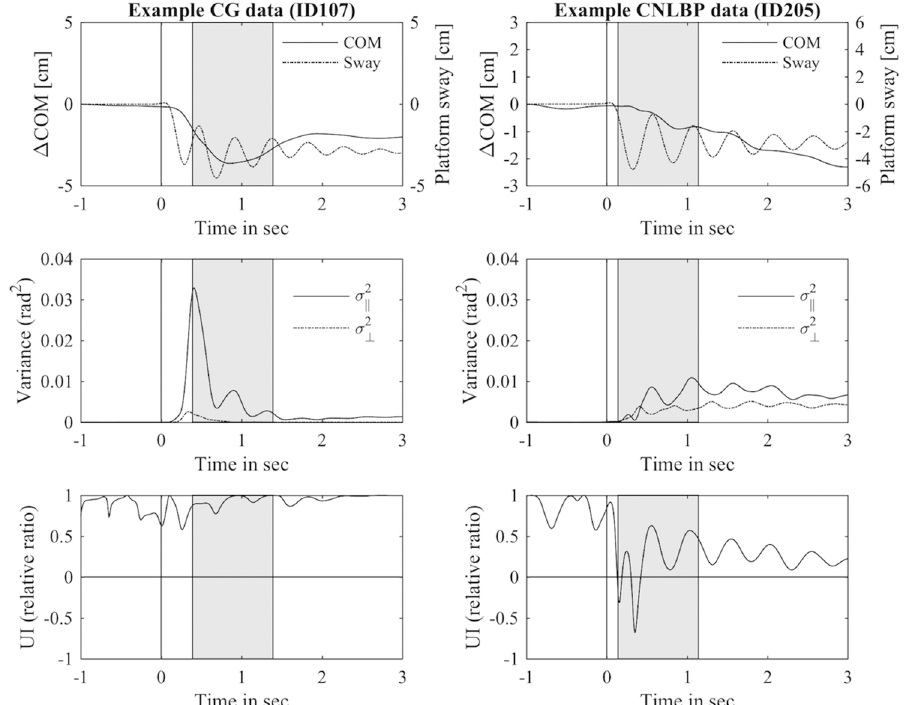
Fig 3. Example data for kinematic analysis. Data of a medium performer (mean UI = .55) from the symptom-free CG (left) and low performer (mean UI = − .47) from the CNLBP group (right). The solid vertical lines indicate time point of platform release. The shaded areas indicate the active response phase (area of interest). The top panel shows CM trajectory and actual platform sway trajectory. The middle panel shows the normalized variance within and perpendicular to pre-perturbation joint configuration space. Lower panel shows the relative ratio of